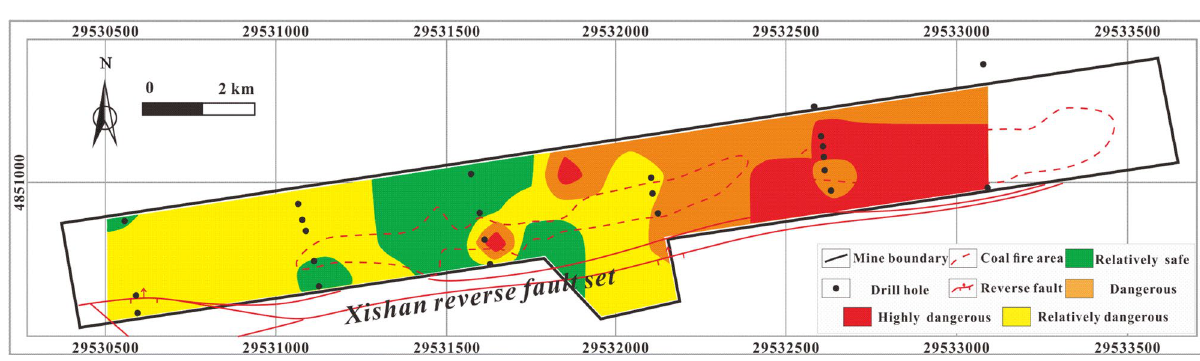
Figure 16. Thematic map of sampling depth in MAPGIS software.